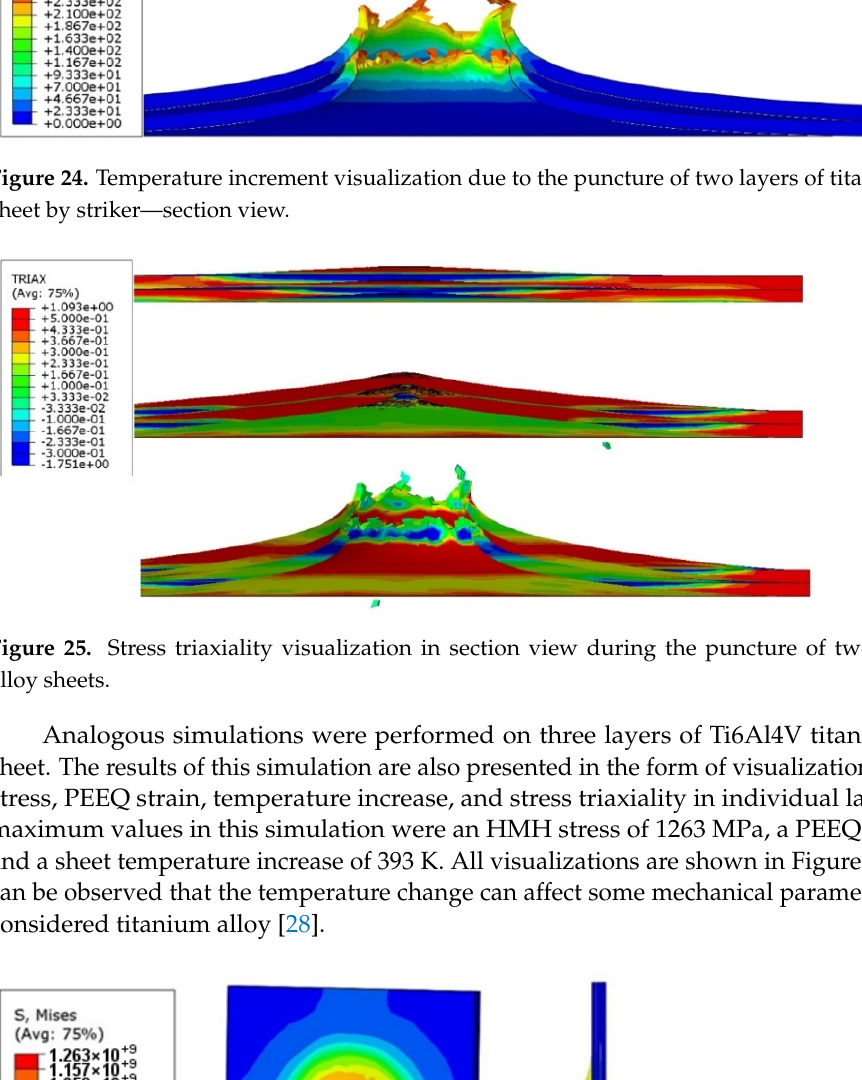
Figure 23. PEEQ visualization for two layers of titanium alloy.